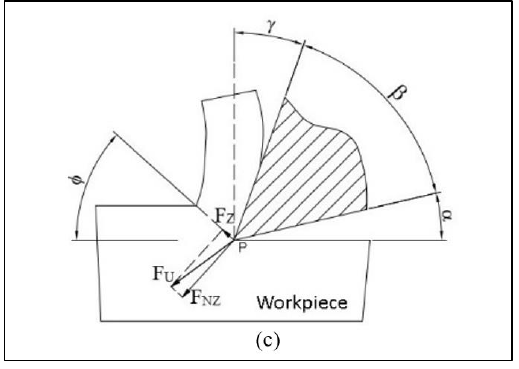
Figure 1c: Machining force components in the work plan: c) shear force (F Z ) and normal shear force (F NZ ).